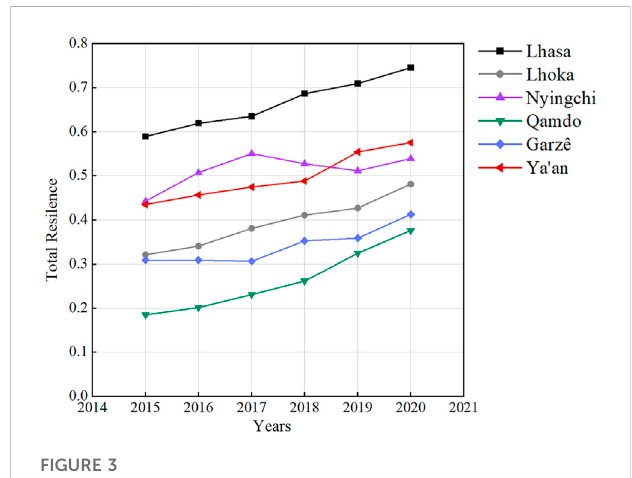
FIGURE 3 Trends in the evolution of the overall resilience level of study objects.